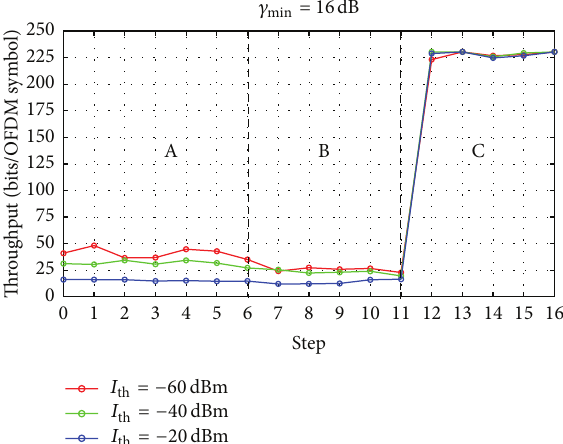
Figure 10: Throughput of the network when MS 1 sends data to MS 5